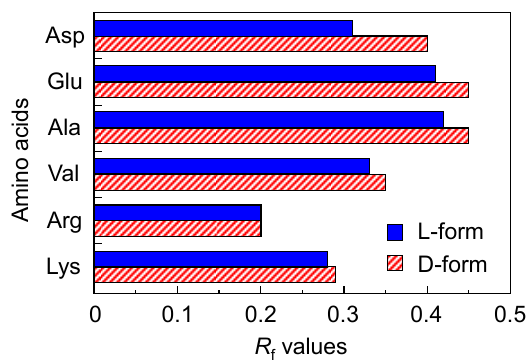
Figure 1. R f values of L- and D-form amino acids on DNA-TLC plate. The mobile phase is entry 1 in Table 1. The amino acid was detected by the ninhydrin reaction. Each of the values represents the mean of three separate determinations.